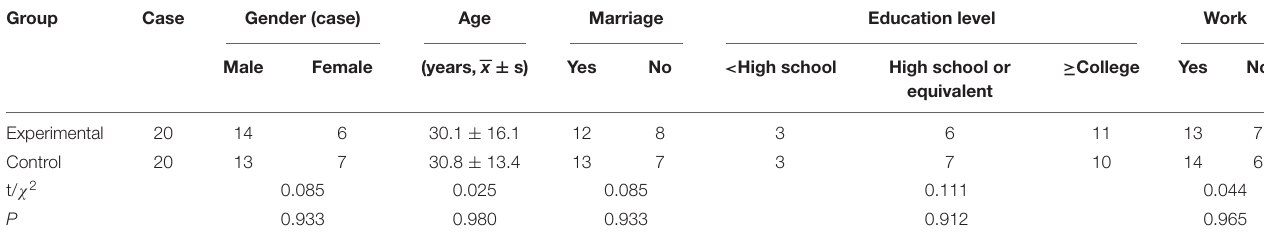
TABLE 1 | Comparison of general information of patients with IBD between the two groups.